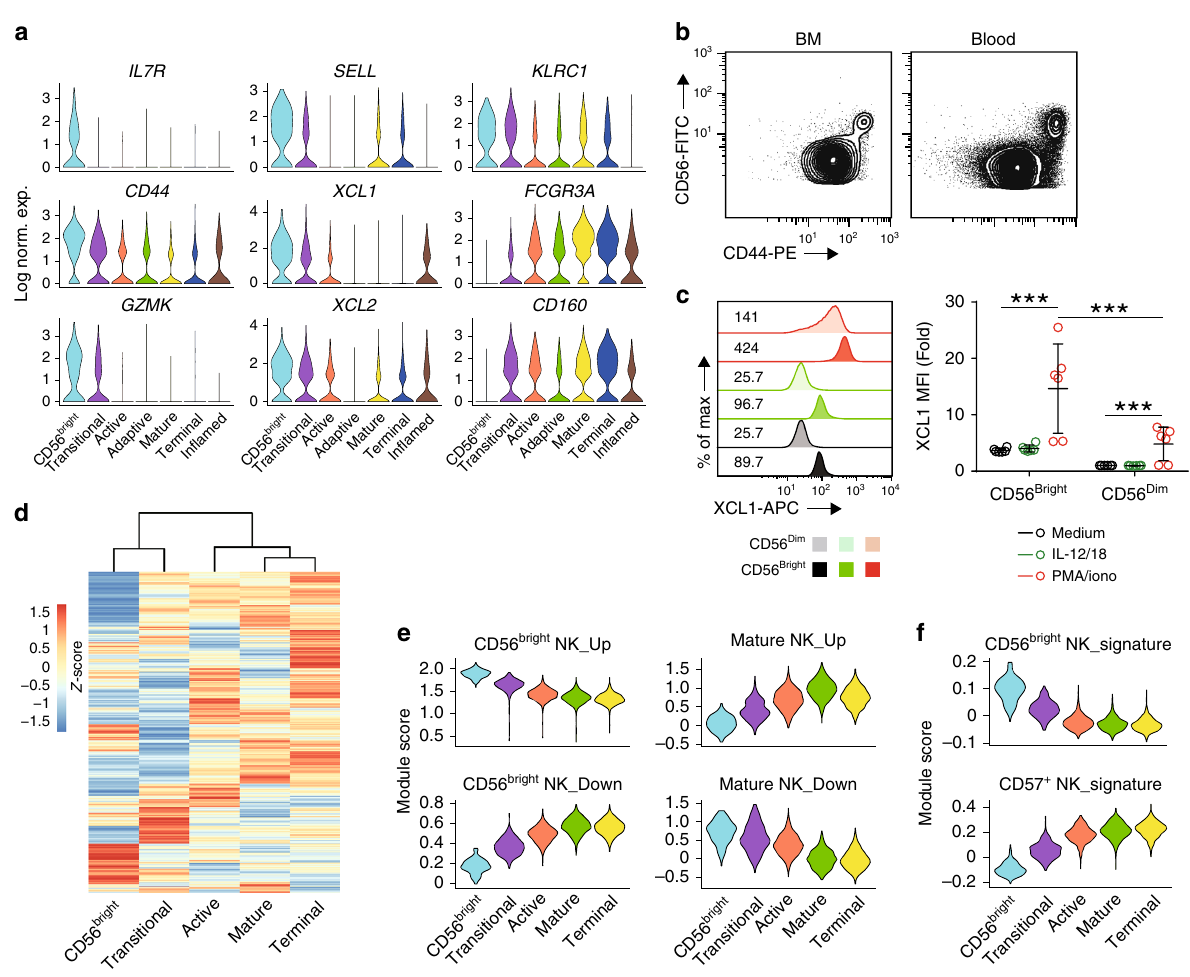
Fig. 3 Identi fi cation of “ CD56 bright NK ” cluster and a potential transitional population between CD56 bright and CD56 dim NK cells. a The expression of genes known to be highly expressed in CD56 bright NK cells was displayed using violin plots of the BM samples. The y -axis represents log-normalized expression value. b The expression of CD56 and CD44 on NK cells from BM (top) or blood (bottom) of healthy donors were assessed via fl ow cytometry. Representative fl ow plot gated on Lin − CD56 + cells were shown. n = 5. c The representative histogram plot on the left demonstrates the production of XCL1 from CD56 bright and CD56 dim NK cells stimulated with medium, IL-12, and IL-18 (10/10 ng/mL), or PMA and ionomycin (50/500 ng/mL) for 6 h. The mean fl uorescence intensity (MFI) of each condition was normalized to the medium-stimulated CD56 dim NK cells and summarized on the right. n = 6 from three independent experiments. Error bars were shown as standard deviation. Two-way ANOVA was used for the statistical analysis. *** p < 0.001. Source data are provided as a Source Data fi le. d The transcriptome similarity among clusters of the blood sample was evaluated by the Euclidean distance and visualized via heatmap. Each row represents a variable gene among clusters, and each column represents one cluster. e Module scores were calculated using up-regulated or down-regulated DEGs of “ CD56 bright and Mature NK ” clusters from blood samples and plotted via violin plots. f Bulk RNA-seq- de fi ned DEGs of CD56 bright and CD56 dim CD57 + NK cells were used to calculate the module score in different clusters of blood samples. See